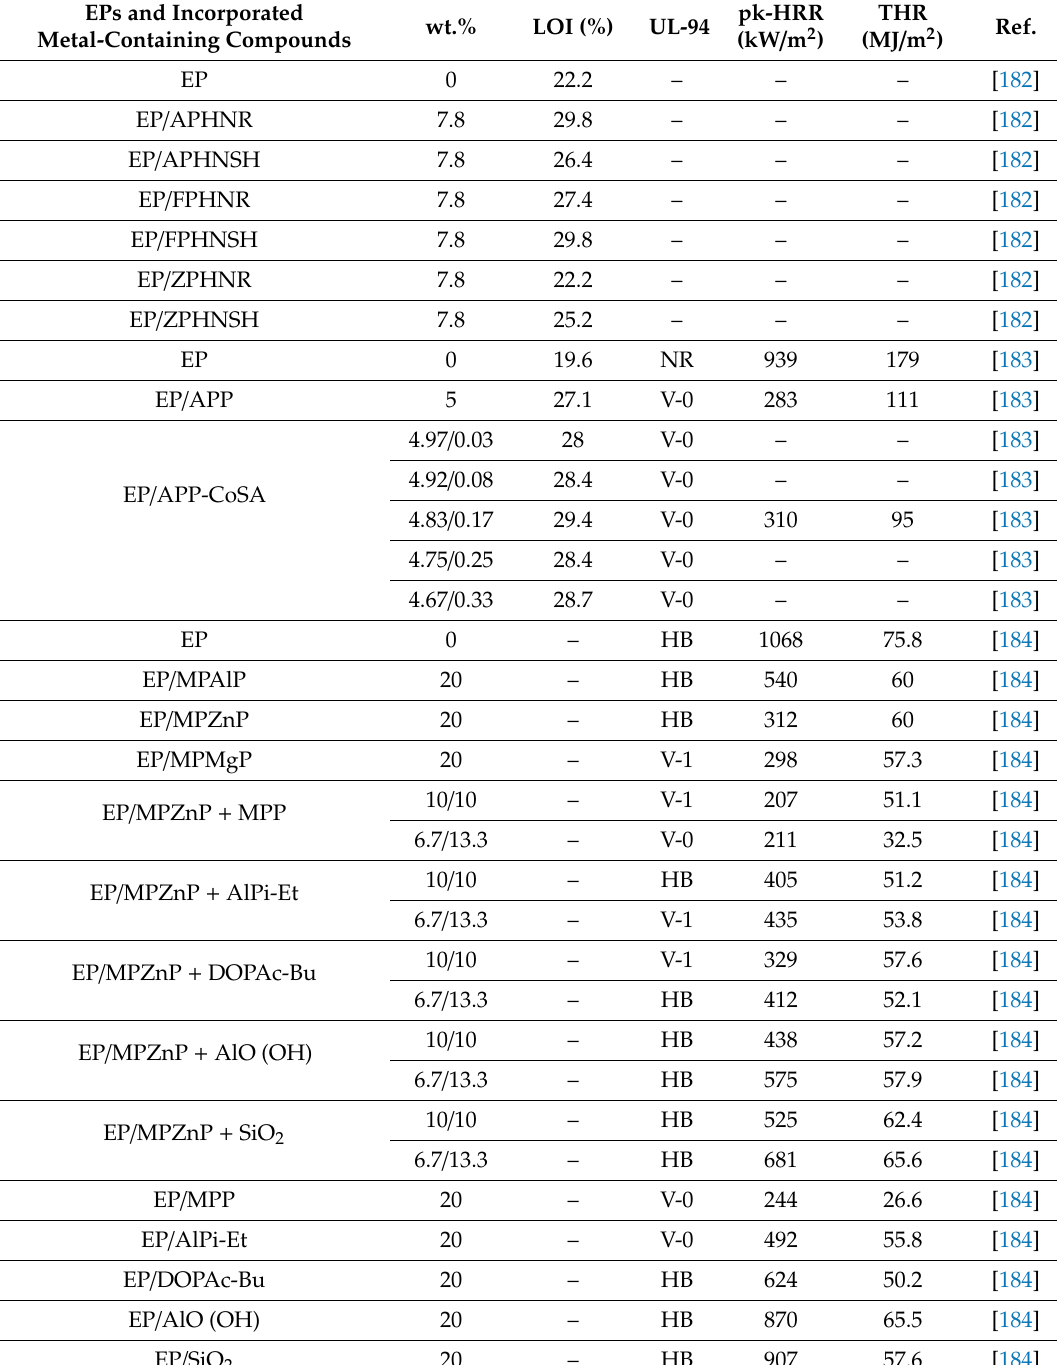
Table 6. The flame retardancy performance of epoxy containing metal-containing